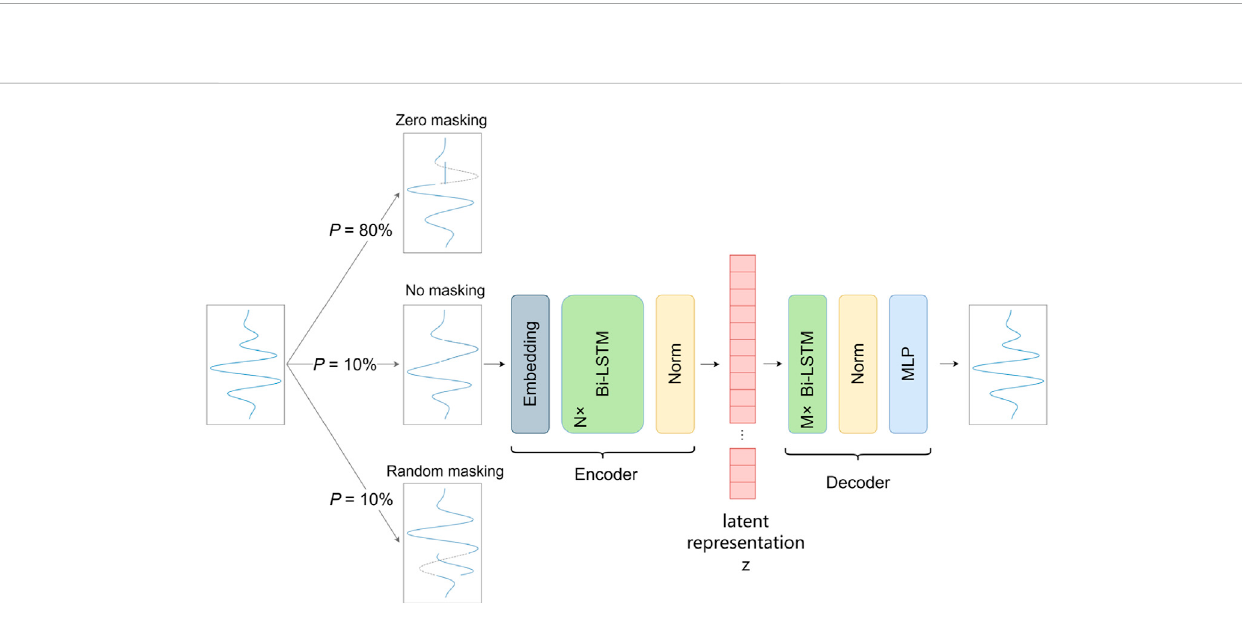
FIGURE 2 Overview of the network architecture and self-supervised